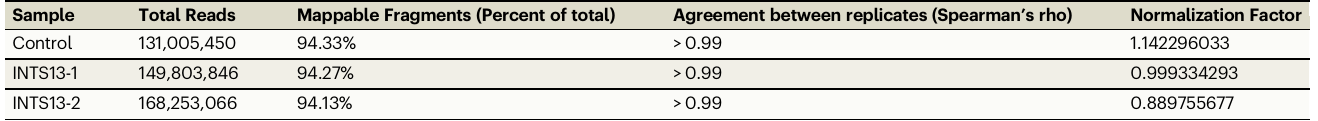
Table 1 | RNA-sequencing statistics